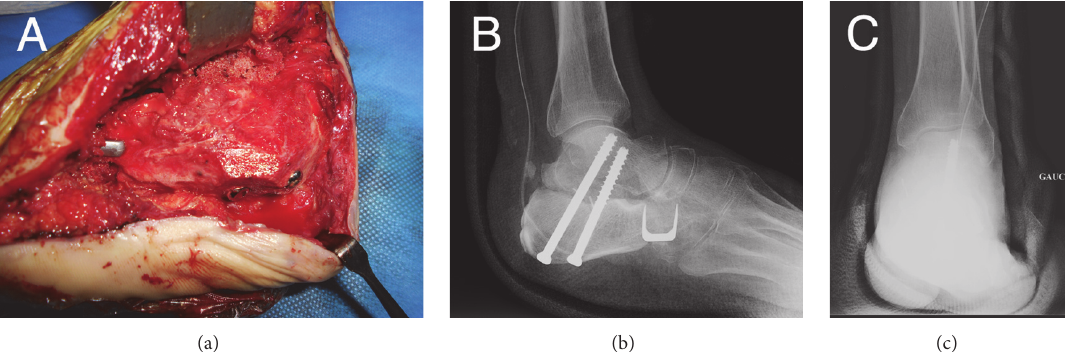
Figure 3: Intraoperative lateral view of the calcaneal allograft arthrodesis (a) and postoperative X-ray examination (b and c) of the calcaneal allograft and double arthrodesis.